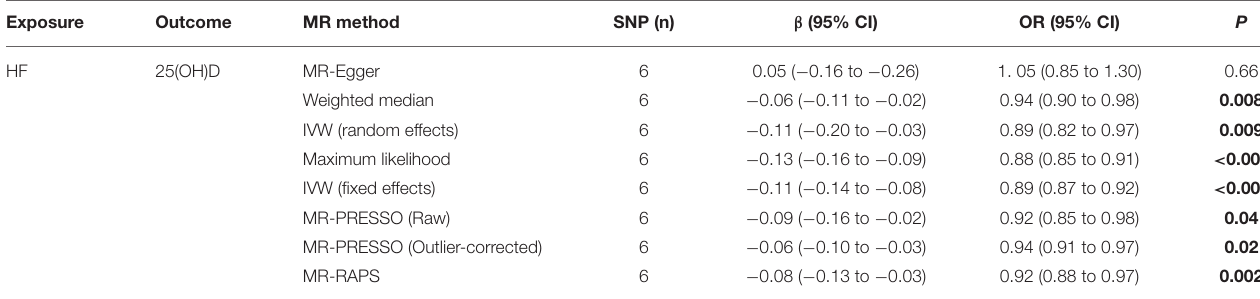
TABLE 3 | Mendelian randomization of the risk of Heart failure and circulating 25-hydroxyvitamin D levels. Exposure